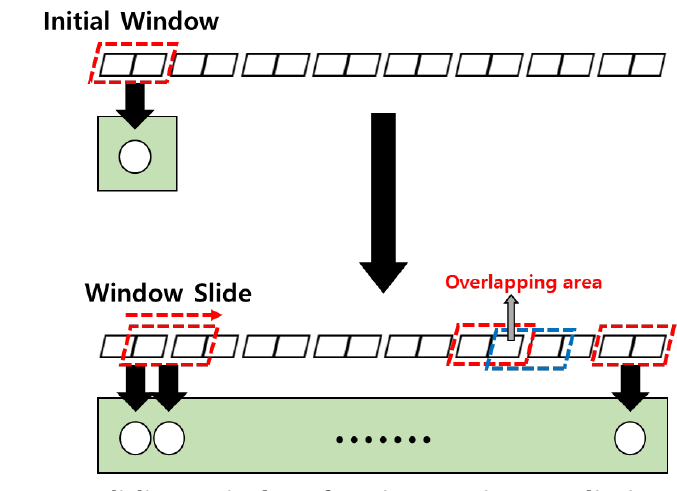
Figure 1. ( Left ) fixed-size window and ( Right ) sliding window for activity recognition.